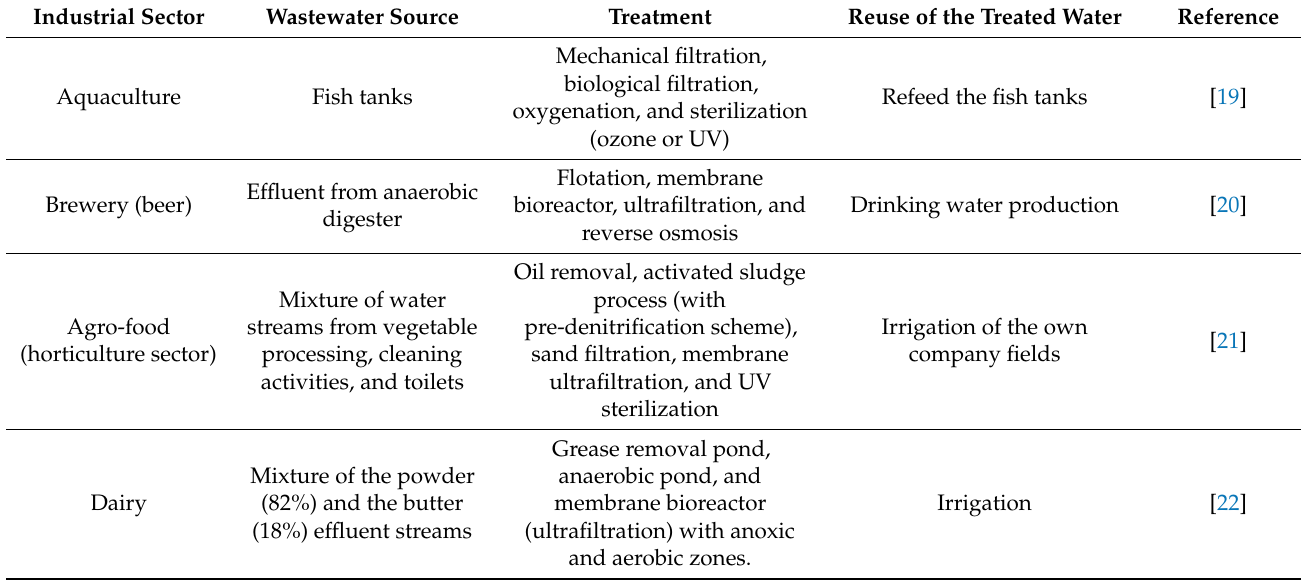
Table 2. Industrial wastewater treatment processes aiming at water